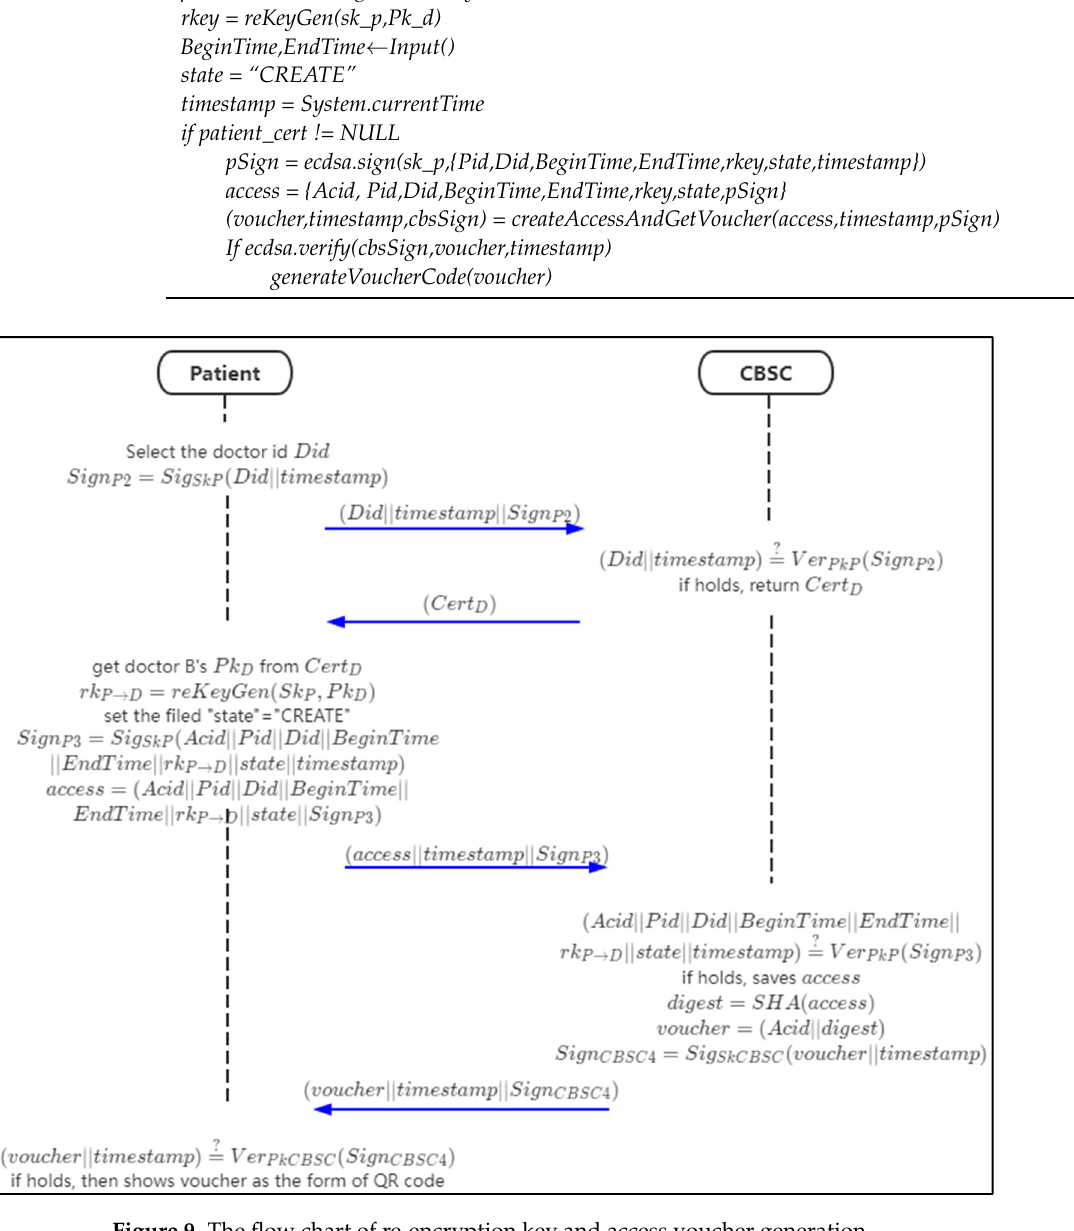
Figure 9. The flow chart of re-encryption key and access voucher generation.